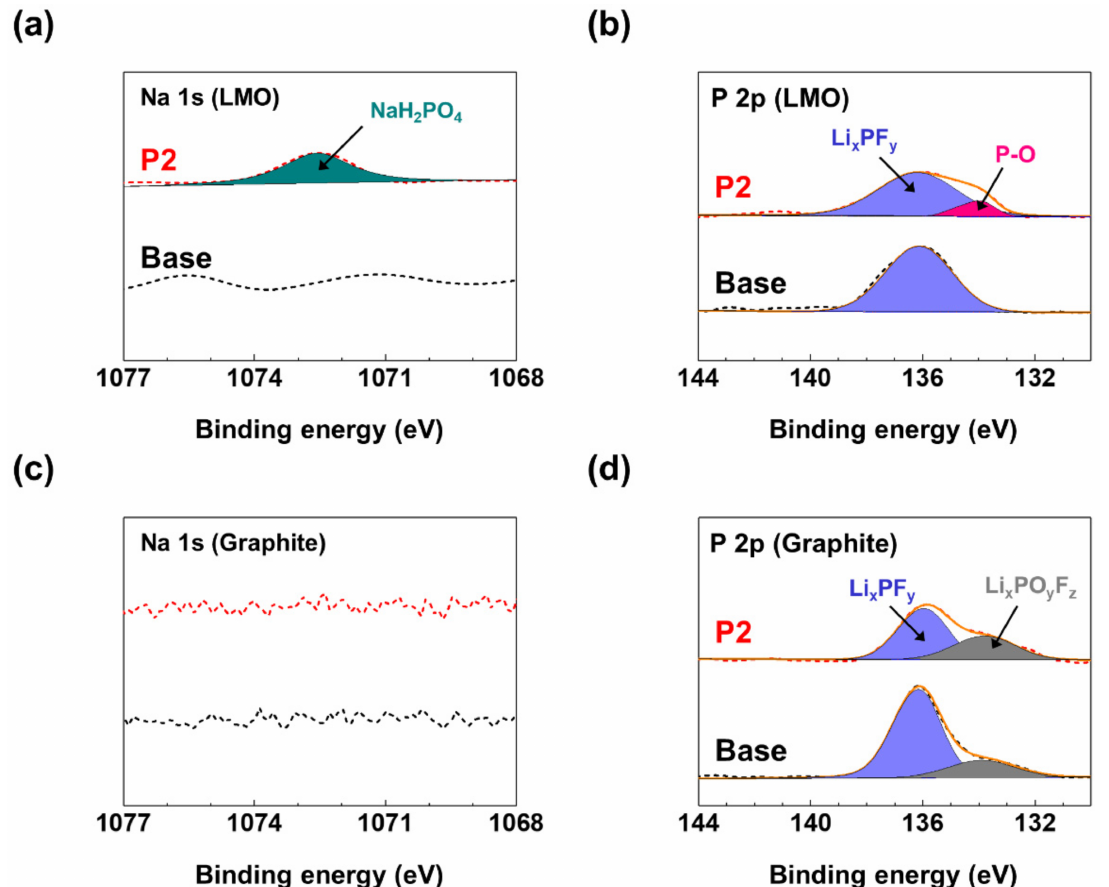
Figure 1. ( a ) Na 1s and ( b ) P 2p XPS spectra of the LMO cathodes with and without P2 additive. ( c ) Na 1s and ( d ) P 2p XPS spectra of the graphite anodes with and without P2 additive. All samples were collected from the LMO/graphite cells after three cycles. Dotted lines denote the experimental spectra and solid lines denote the best-fitted